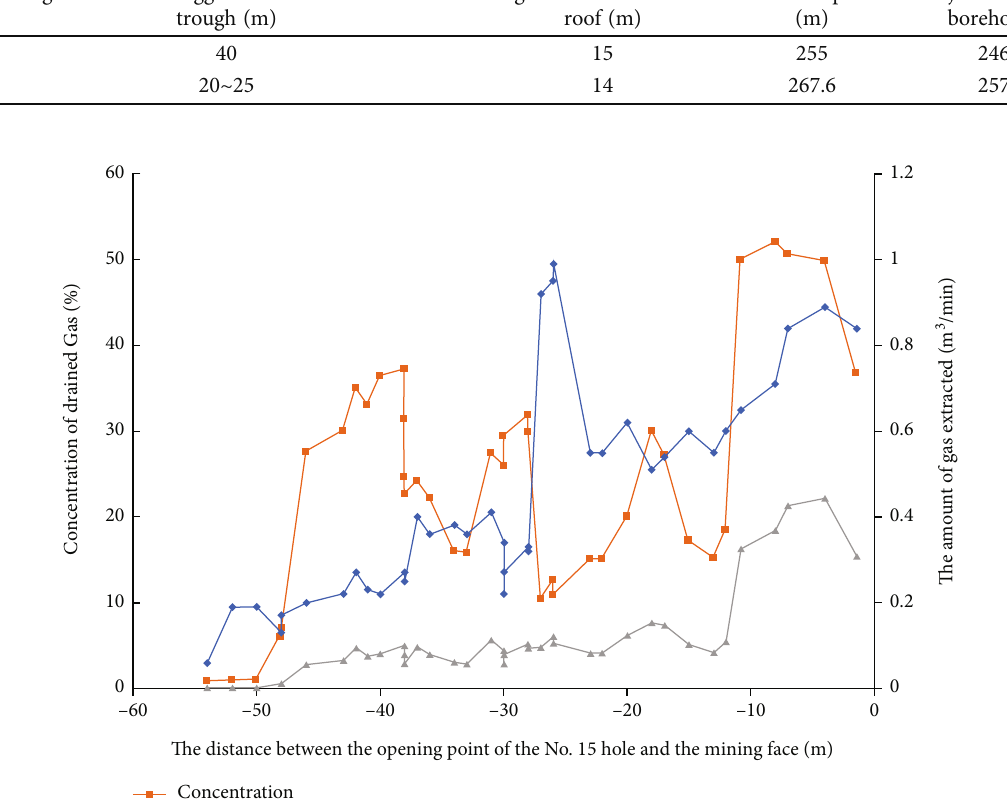
Figure 7: The relationship between the extraction parameters and the advancing step distance of No. 15